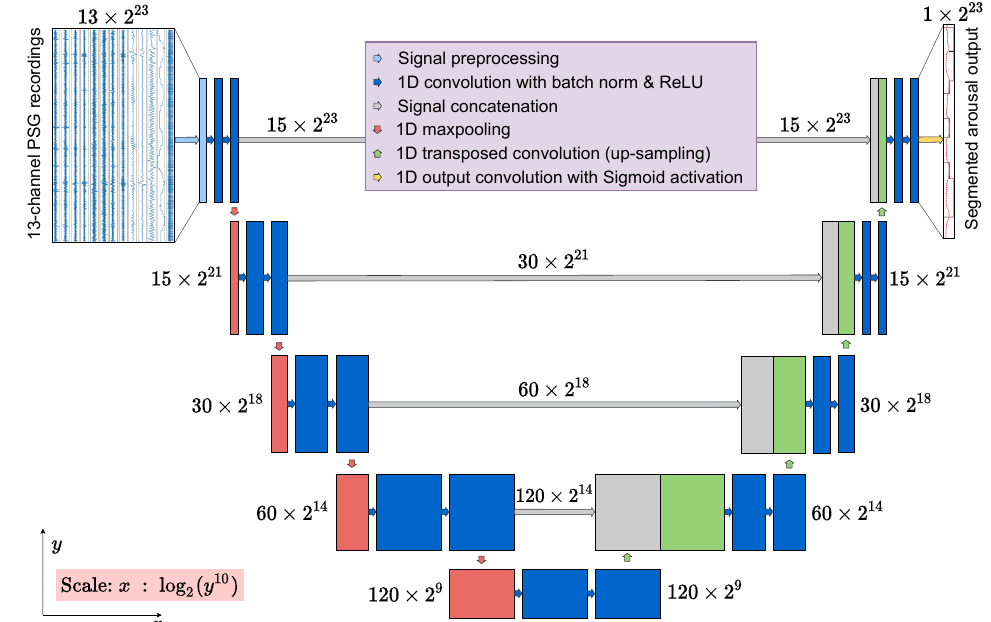
Figure 3. The proposed DeepSleep 2.0 architecture. The structure is a 1D adaptation of the well- known 2D U-Net architecture [29]. Compared to DeepSleep [4], the proposed architecture only has a depth of 5, while DeepSleep has a depth of